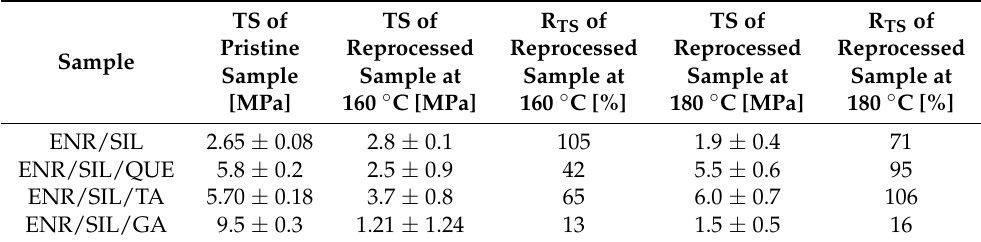
Table 1. Tensile strength (TS) results of ENR/silica composites with natural phenolic compounds before and after reprocessing at 160 ◦ C and 180 ◦ C with effectiveness of reprocessing calculated using tensile strength results (R TS (%)).